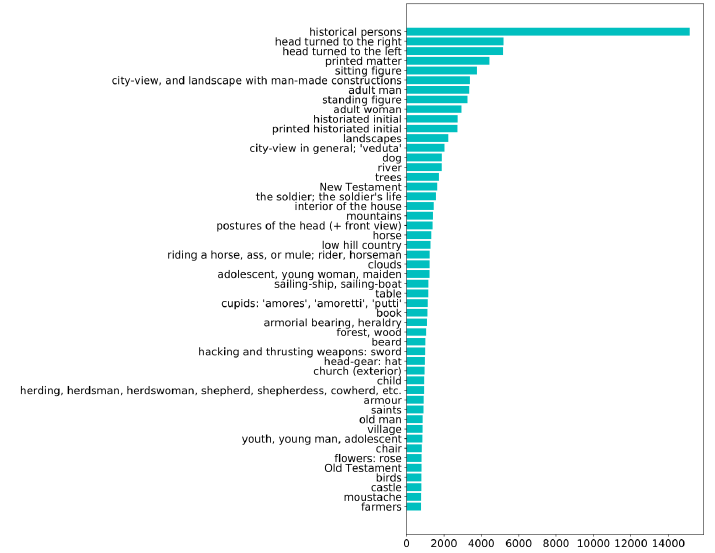
Figure 2. Distribution of textual descriptions in the Iconclass Caption dataset showing the 50 most commonly occurring words/phrases (Iconclass codes) in the whole